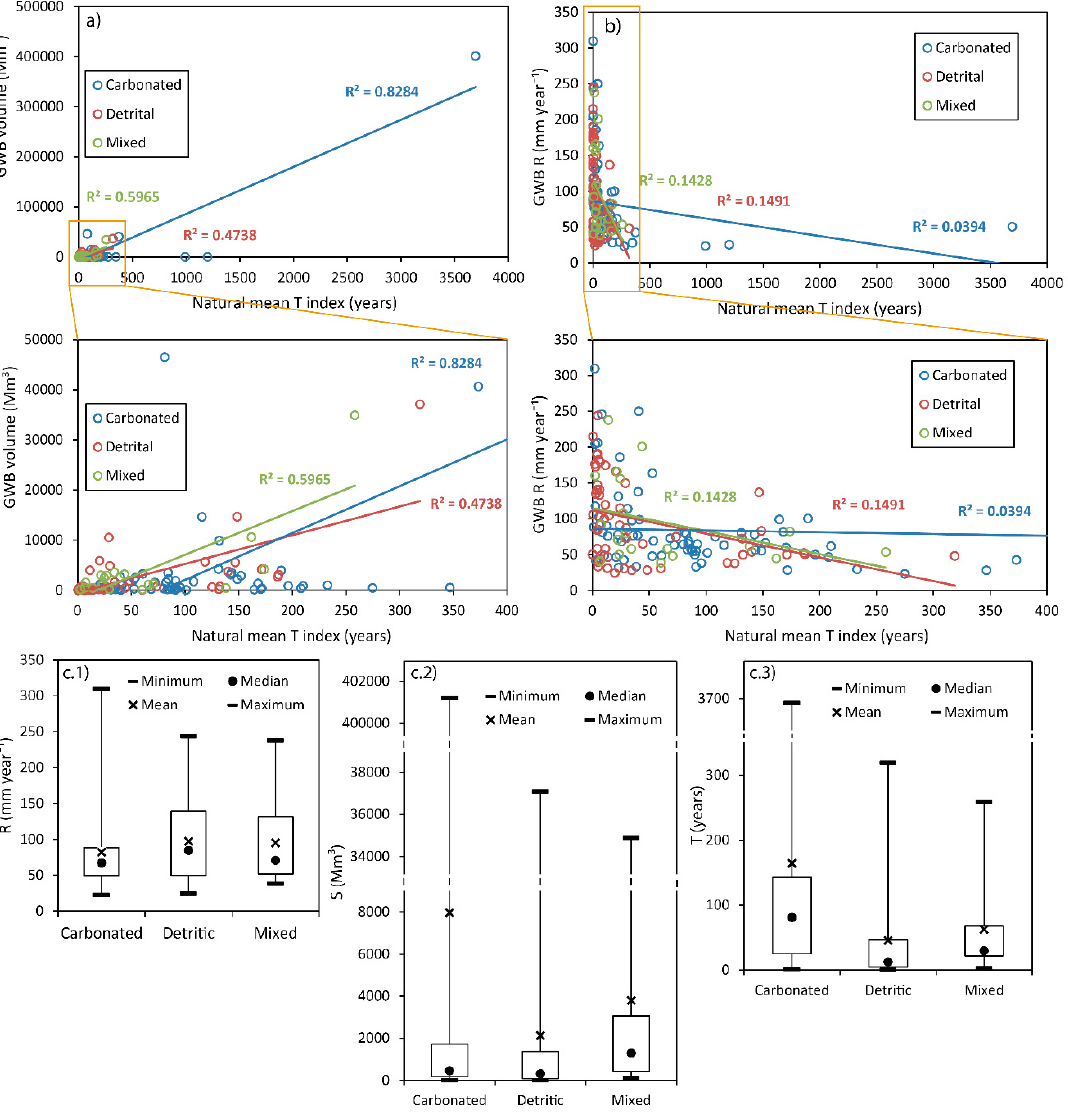
Figure 9. ( a ) GW body volume (Mm 3 ) vs. natural mean T index (year), ( b ) R (mm year –1 ) vs. natural mean T index (year), T and ( c ) box-whiskers of R, S and T for the three considered GW bodies lithological categories: carbonated, detrital, and mixed.